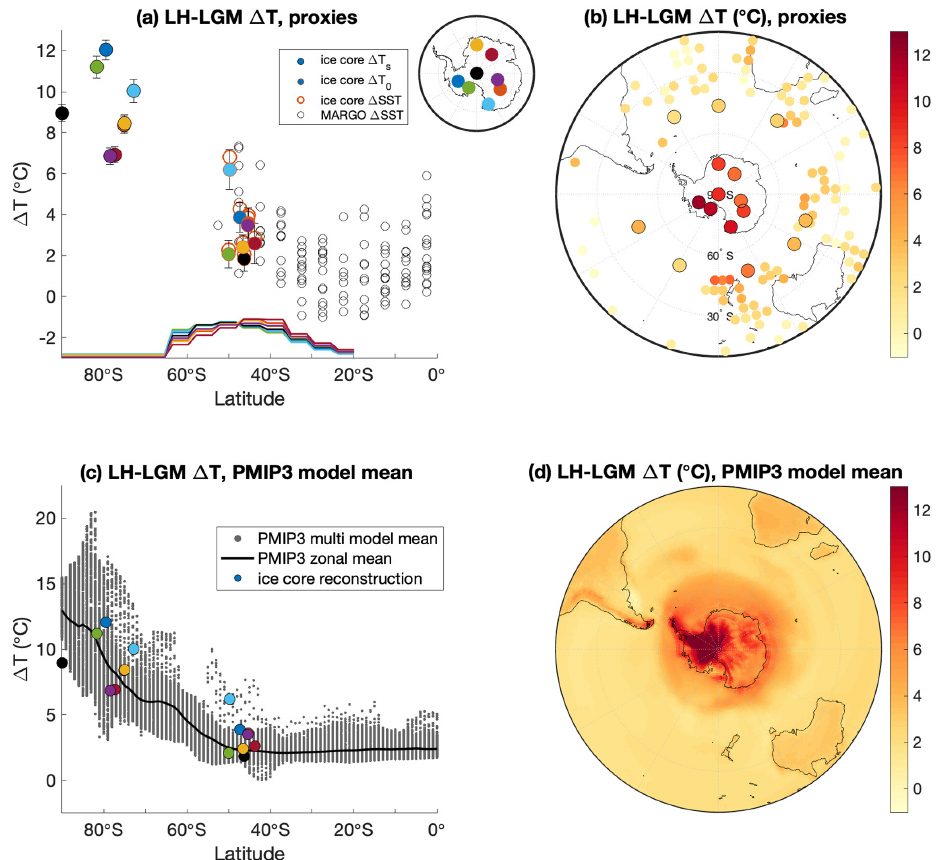
Figure 14. Spatial pattern of temperature change since the Last Glacial Maximum. (a) Warming between 19–23 and 0–4ka for ice-core site surface temperatures (colored circles with black outline corresponding to different ice-core sites as shown in map inset, uncertainty in the temperature change shown as error bars), moisture source evaporation air temperature (colored circles, red outline and uncertainty), and moisture source sea surface temperature (red circles). Moisture source warming is plotted at the mean latitude of the modern moisture source distributions for each ice-core site, while the latitudinal extent of each moisture source is indicated by the relative histograms along the x axis. Sea surface temperature warming from the MARGO compilation of SST estimates from ocean sediment cores is shown as open black circles. (b) Ice-core site surface temperature changes and moisture source sea surface temperature changes are shown as large colored circles with black outline. MARGO compilation SST changes are shown as small colored circles. (c, d) Spatial pattern of temperature change from the multi-model mean PMIP3 simulations of the LGM and pre-industrial. (c) The multi-model mean for all grid points is shown as grey dots with the zonal mean in black. Estimates of (cid:49)T s and (cid:49)T 0 from the ice-core reconstructions are shown as colored circles as in (a) for